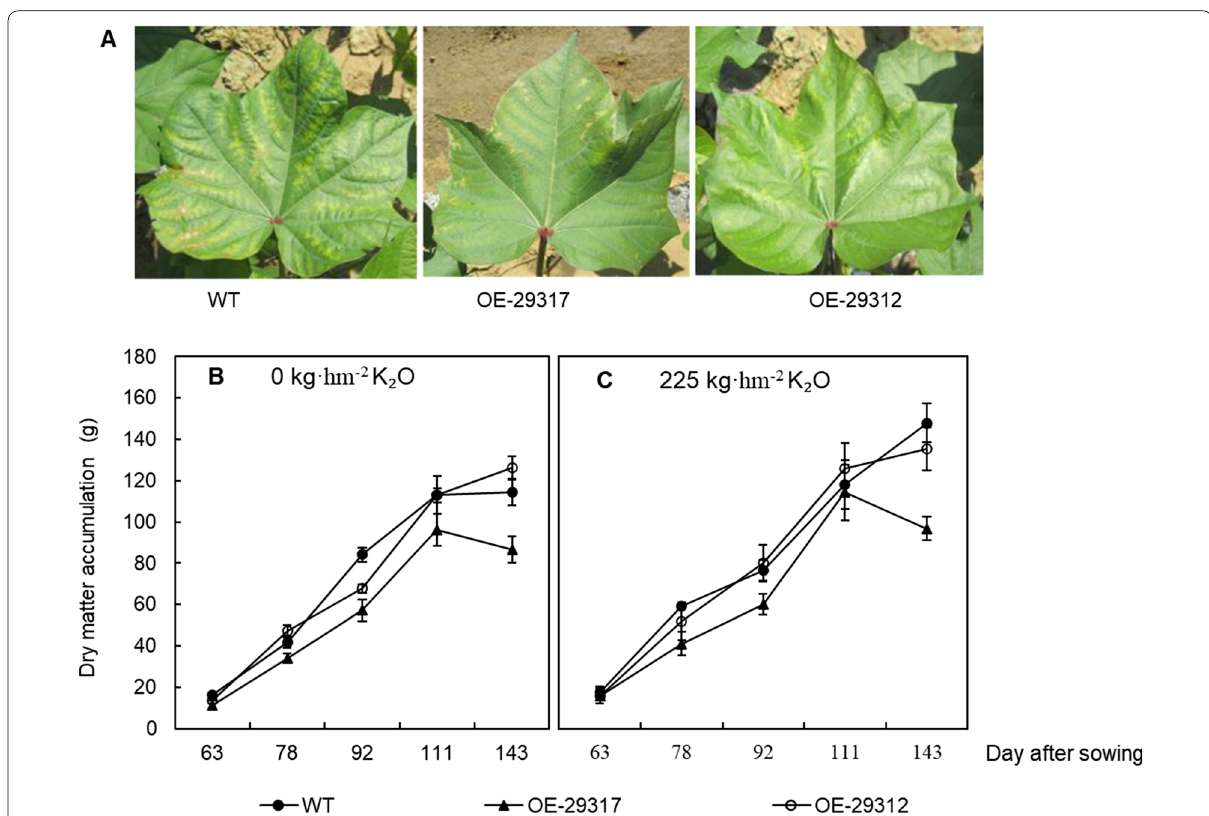
Fig. 1 Effects of Bacillus thuringiensis ( Bt ) gene on the symptoms of potassium (K) deficiency in the youngest fully expanded leaf (the fourth leaf from apex) 61 days after sowing in the field ( A ), dry matter production of cotton plants in plots without ( B ) or with ( C ) K fertilizer (225 kg The available K + in soil was 47.8 mg kg − 1 . DAS: days after sowing. WT: wild type (Jihe 321); OE-29317 and OE-29312: transgenic Bt ·